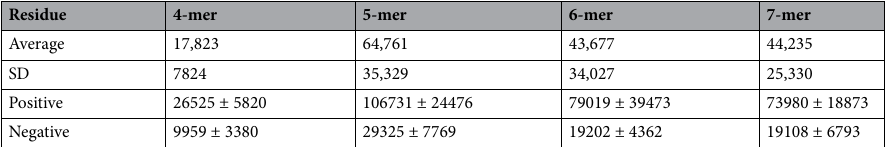
Table 1. Average of the fluorescence intensities of top 150 positive and bottom 150 negative training datasets, based on the rank of fluorescent intensities.